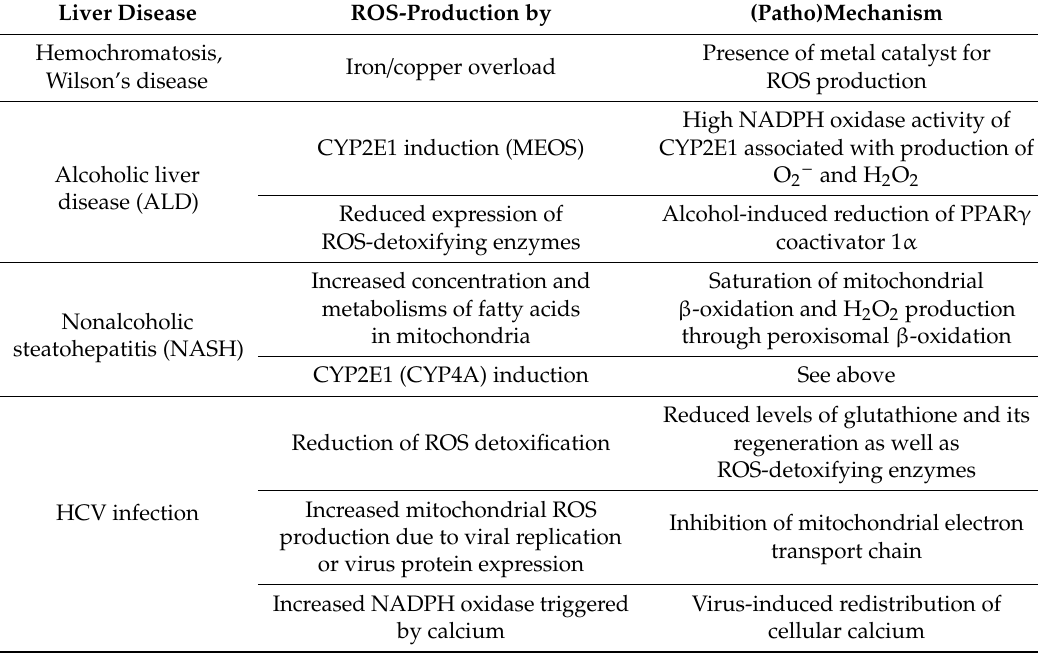
Table 1. Involvement of ROS in various liver diseases. Based on